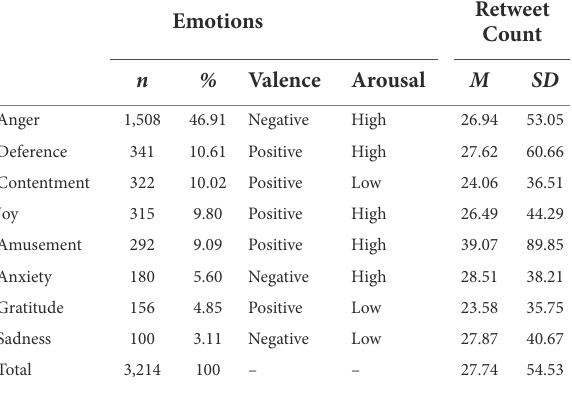
TABLE 1 Studied emotions with retweet count per